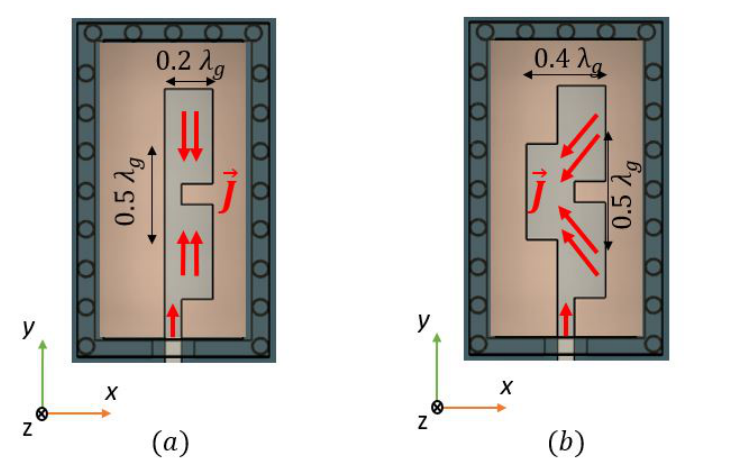
Figure 2. Top view of the current distribution at f 0 = 26.5 GHz of ( a ) the transition without overlap- ping, ( b ) the transition with